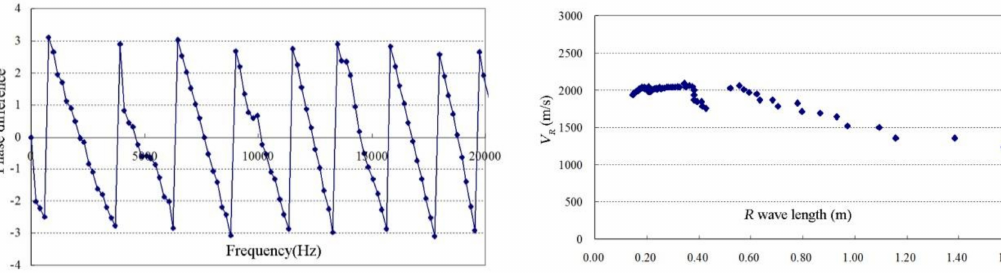
Figure 12. Phase spectrum and dispersion curve of the layered model 3 @ receiver spacing 80